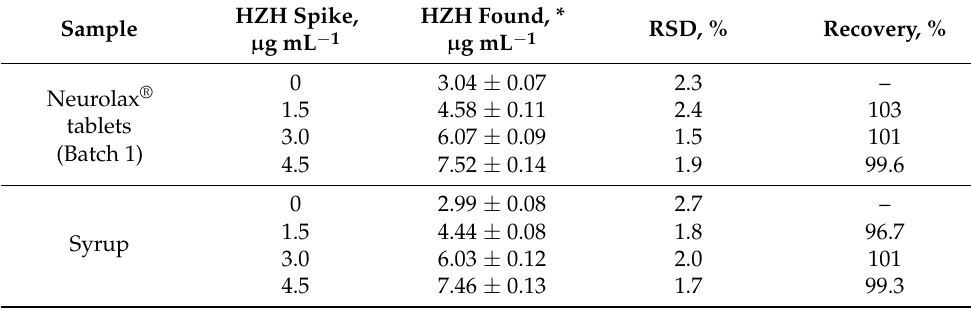
Table 4. Determination ( n = 4) of HZH in unspiked and spiked